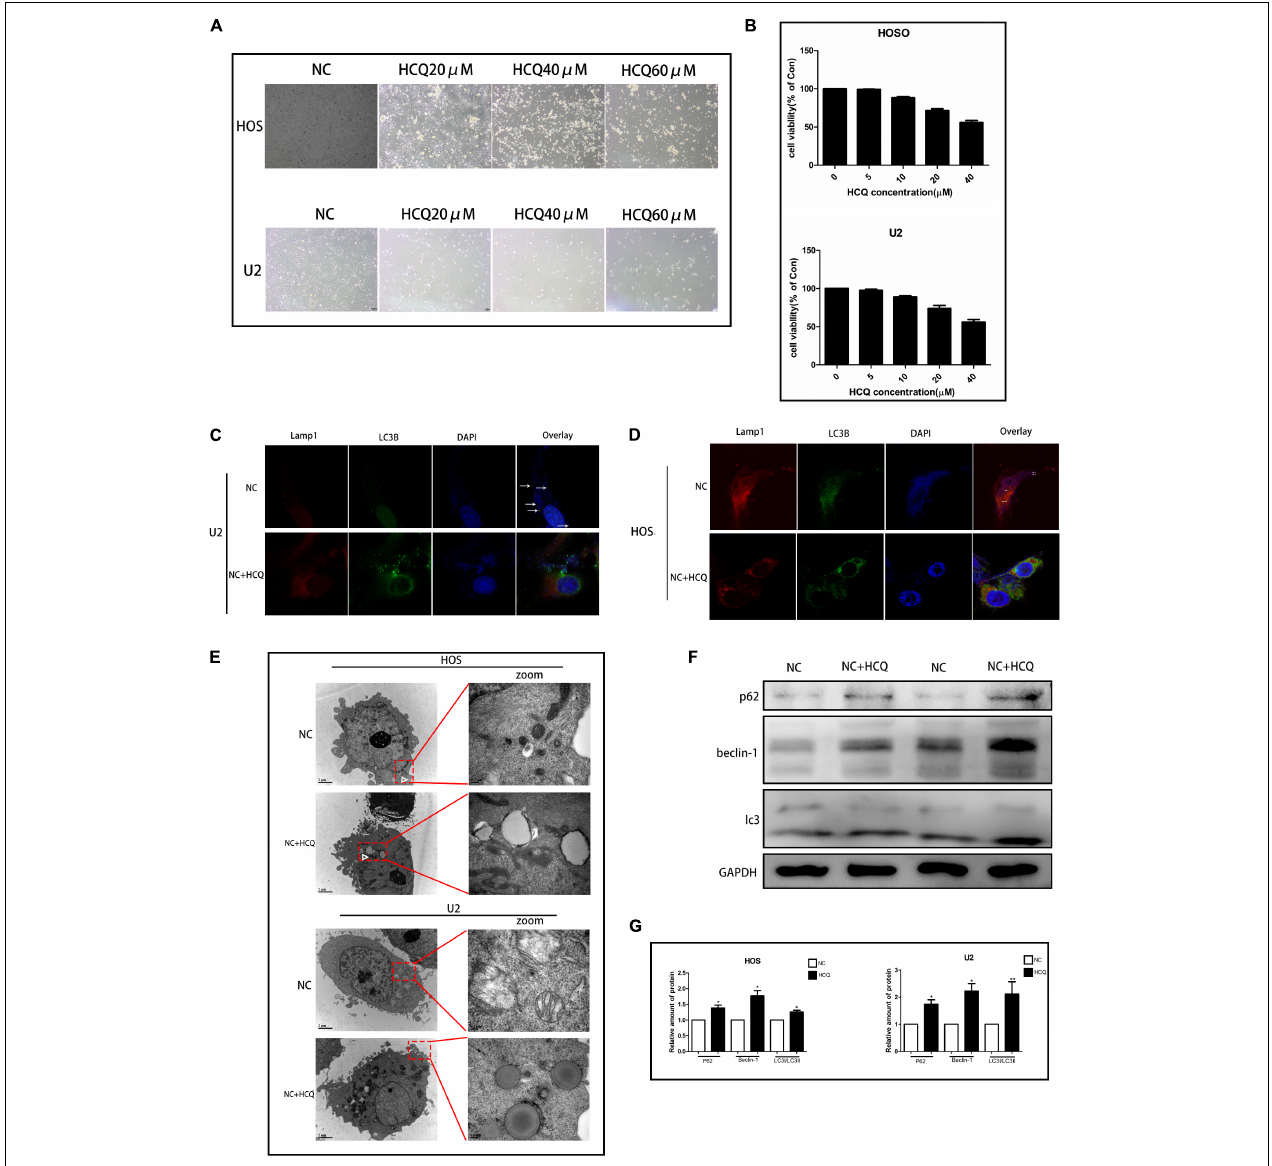
FIGURE 5 | HCQ inhibits the activity of OS cells. (A) Cell morphology. (B) CCK8 proliferation analysis. (C,D) Immunofluorescence co-staining of Lamp-1 (red) and LC3B (green) in OS cells 24 h post-HCQ treatment. (E) TEM images of HCQ-treated OS cells after 6 h and 24 h. Autophagosomes are indicated by white arrows. (F,G) Western blotting and densitometric quantification ( n = 5 per group; ** p < 0.01 versus NC group; * p < 0.05 versus NC group).